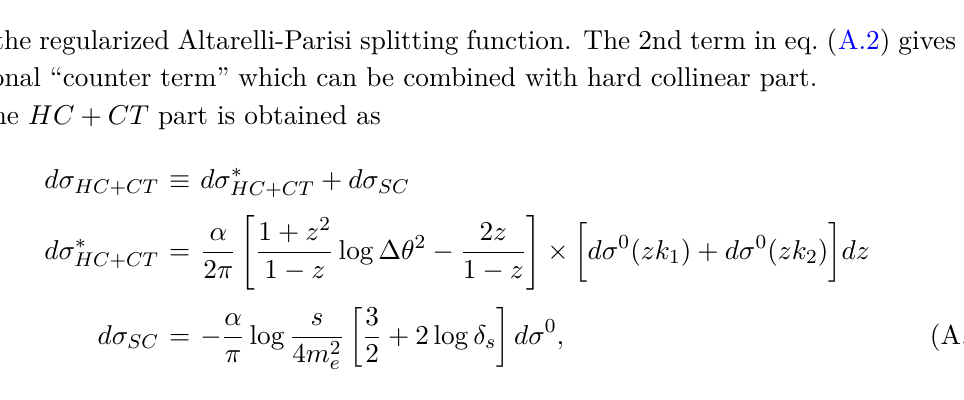
Figure 17 . One-loop corrections of e + e − → H 0 A 0 as functions of δ s , ∆ θ and k .